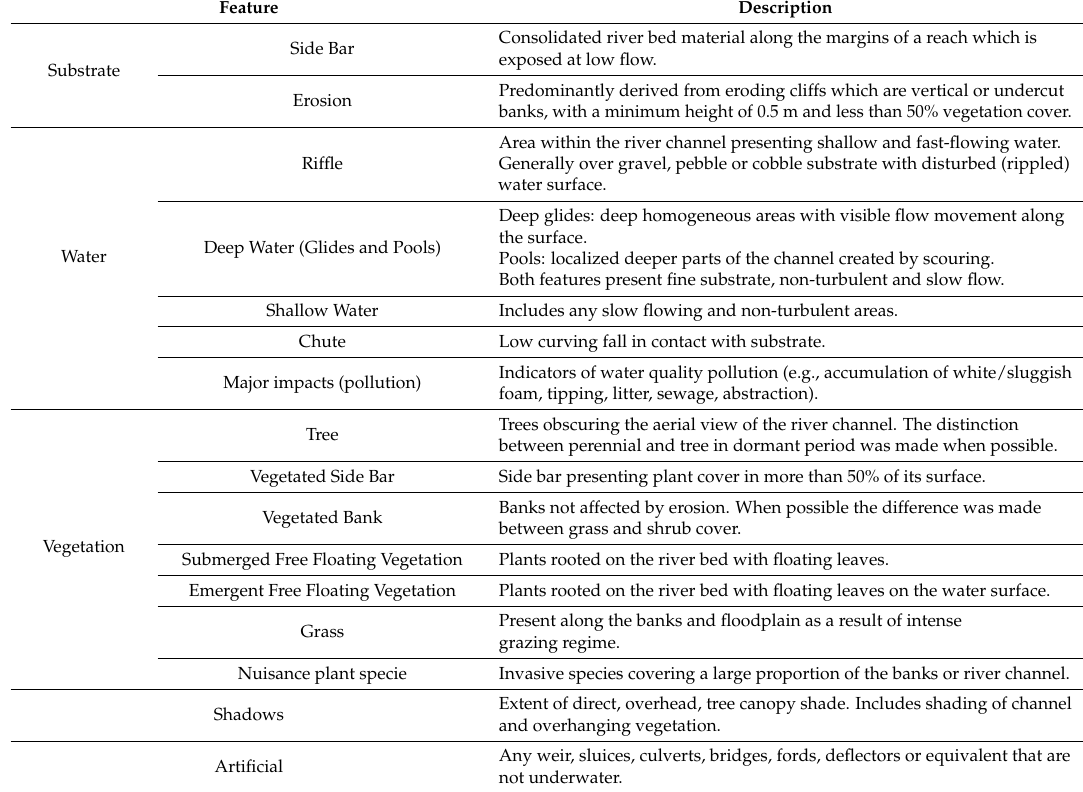
Table 2. Description for each of the hydromorphological features identified within the selected study sties. The features are adapted from the River Habitat Survey [11], the key method for the hydromorphological assessment of rivers in UK and for the designation of the water body [36]. This was further supported by the features used by the Spanish methodologies [37–41]. The water features recorded extended for over 5 m or >1% of the channel length following [11]. These features were recorded even if they were the result of an artificial